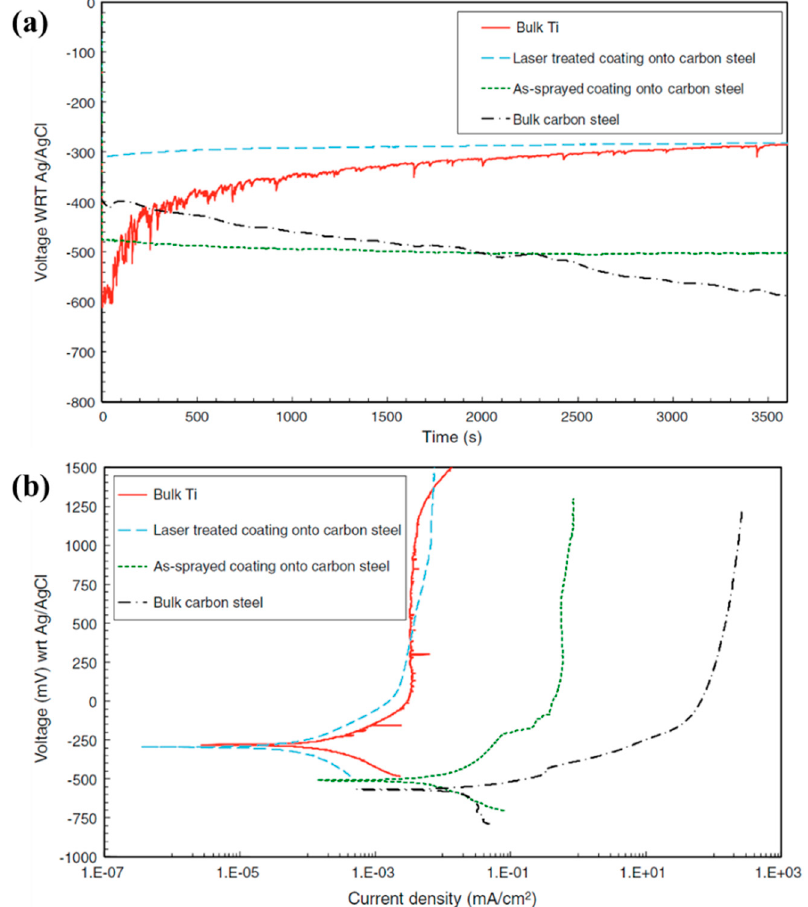
Figure 18. ( a ) Open circuit potentials (OCPs) and ( b ) potentiodynamic polarization scans of bulk Ti, carbon steel, as-sprayed Ti coating (on carbon steel), and laser-treated Ti coating measured in an aerated 3.5% NaCl solution (adapted from reference [83], with permission from © Springer Nature).